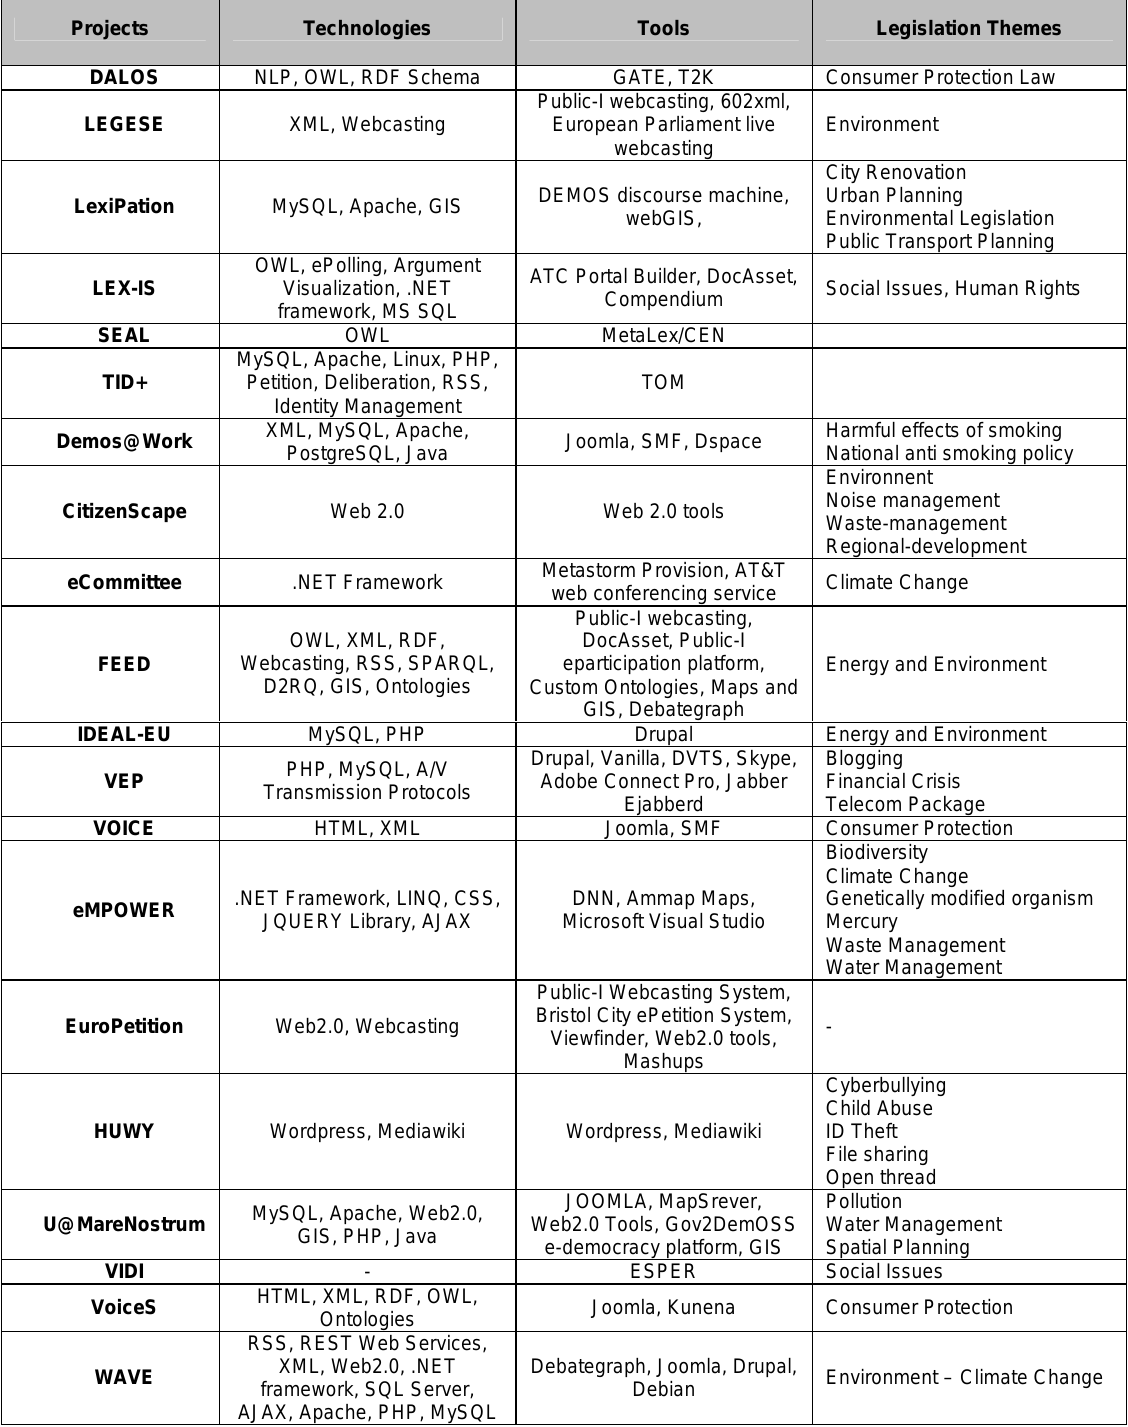
Table1: Overview of Projects Consolidation